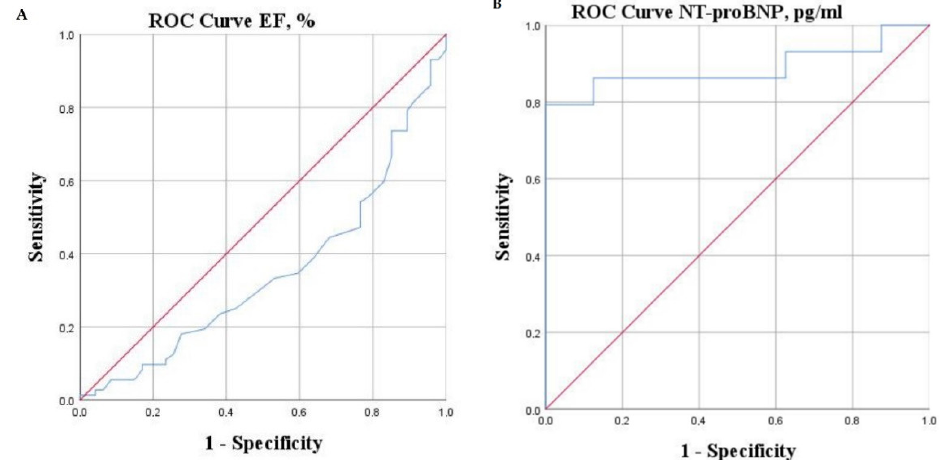
Figure 1. ROC curves of LVEF ( A ) and NT-pro-BNP ( B ).